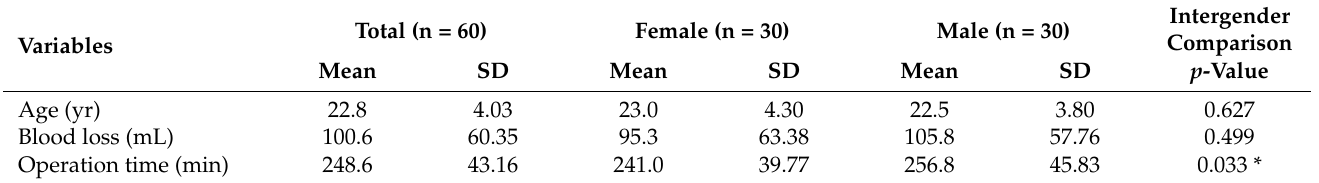
Table 1. Patient characteristics.